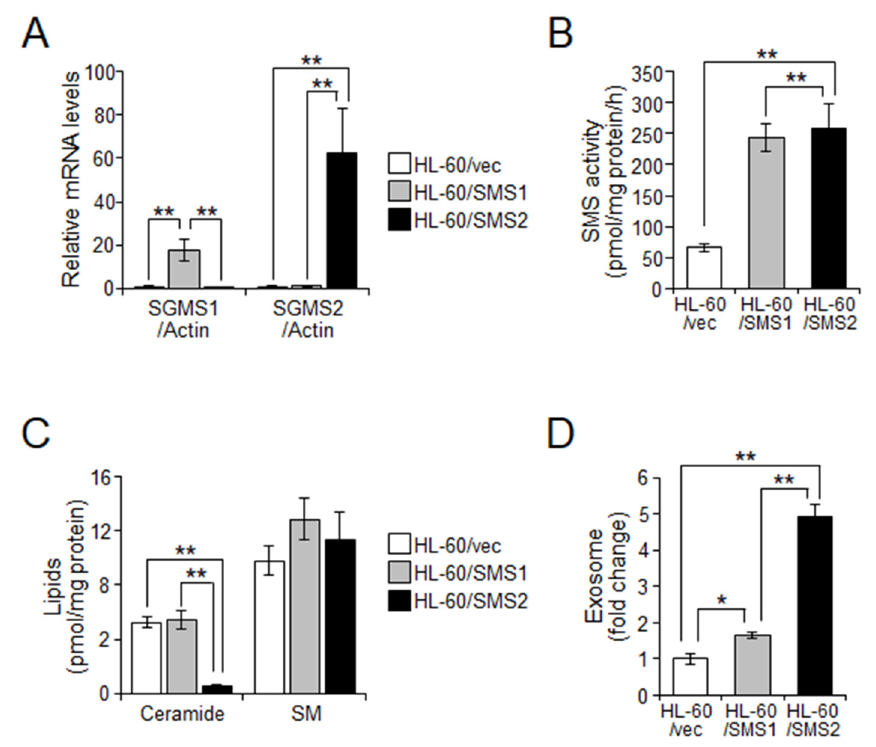
Figure 4. Overexpression of SMS2 increases exosome release in HL-60 cells. HL-60 cells overexpress- ing SMS1 or SMS2 were established by retroviral infection of hSMS1 (HL-60/SMS1) and hSMS2 (HL-60/SMS2). As a control, retrovirus vector containing empty vector was used (HL-60/vec). ( A ) qPCR analysis of SGMS1 (SMS1) and SGMS2 (SMS2) in HL-60/vec, HL-60/SMS1, and HL-60/SMS2 cells. Expression was normalized against ACTB expression ( n = 3). ( B ) Cellular SMS activity was analyzed using C 6 -NBD-ceramide as the substrate ( n = 3). ( C ) Ceramide and SM contents were measured by LC-MS/MS and normalized against cellular protein amounts ( n = 4). ( D ) Exosome numbers were measured by Nanosight ( n = 3). Values indicate mean ± SD. * p < 0.05, ** p < 0.005.